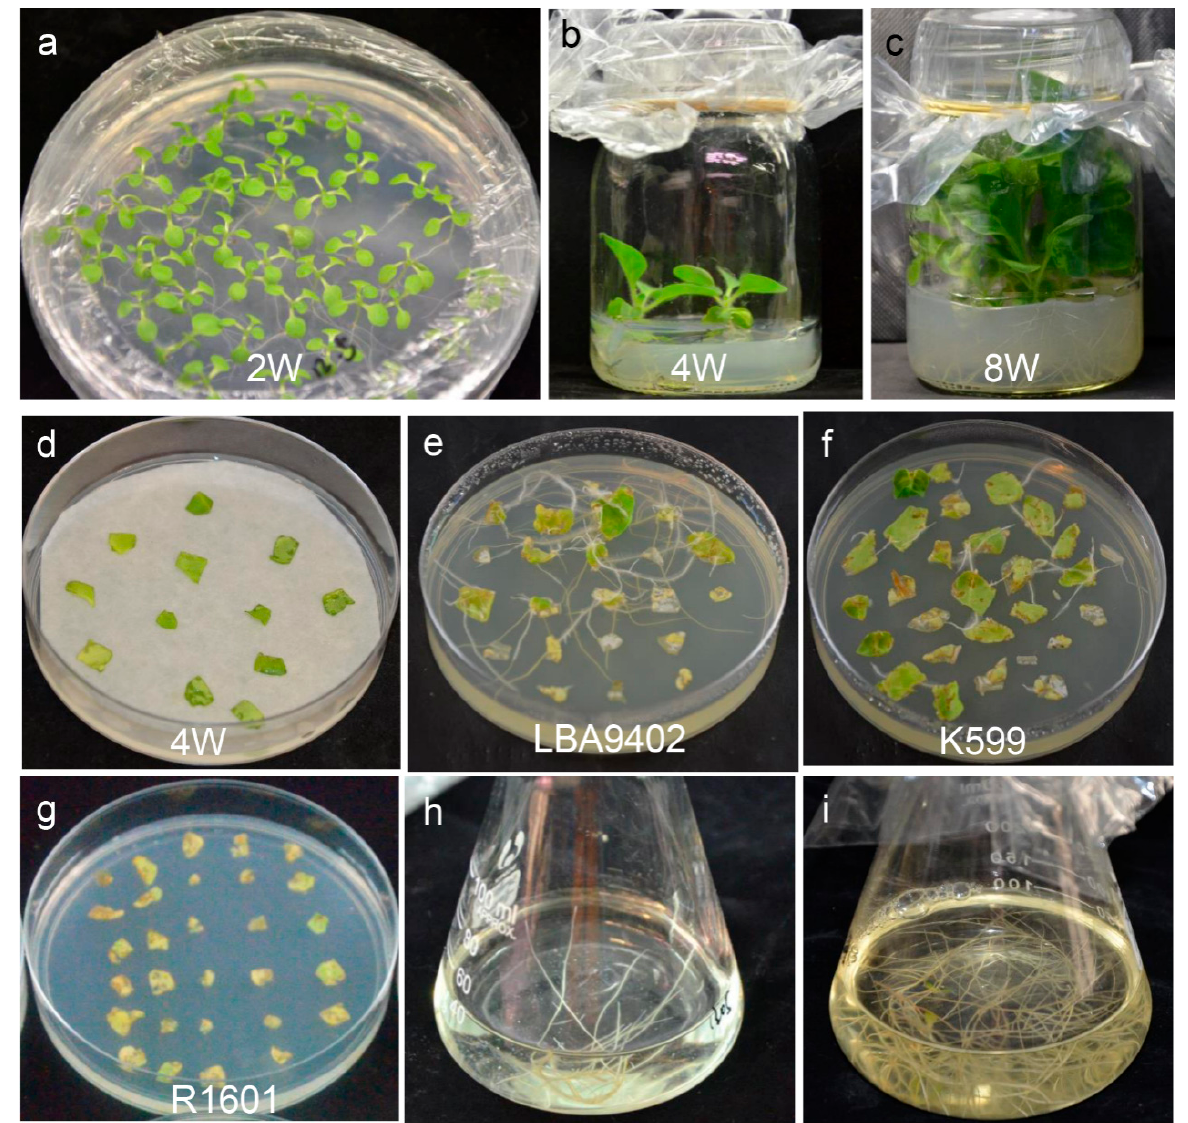
Figure 1. R. rhizogenes -mediated tobacco hairy root induction: ( a ) 2 week old tobacco plants’ ( b ) 4 week old tobacco plants; ( c ) 8 week old tobacco plants; ( d ) a typical photograph of 4 week old tobacco leaf discs after cocultivation for 3 days’ ( e ) induction tobacco hairy roots with R. rhizogen strain LBA9402 for 1 month; ( f ) induction tobacco hairy roots with R. rhizogen strain K599 for 1 month; ( g ) induction tobacco hairy roots with R. rhizogen strain R1061 for 1 month; ( h ) hairy roots inoculated in 2/3 MS liquid medium; ( i ) growth state of hairy roots cultured in liquid medium for 1 month.